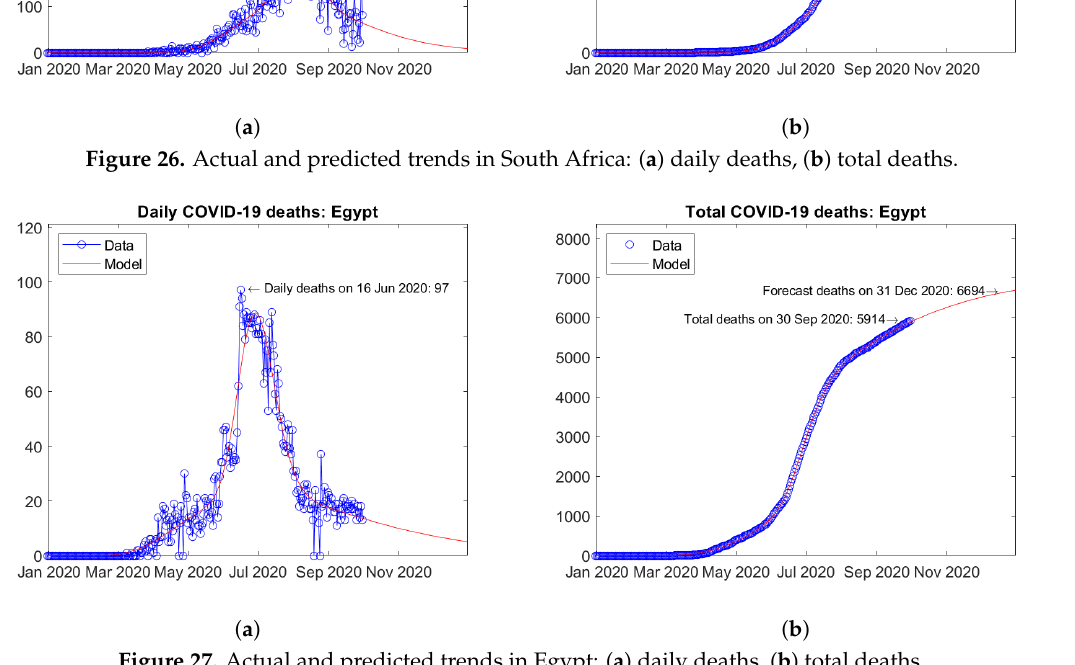
Figure 27. Actual and predicted trends in Egypt: ( a ) daily deaths, ( b ) total deaths.